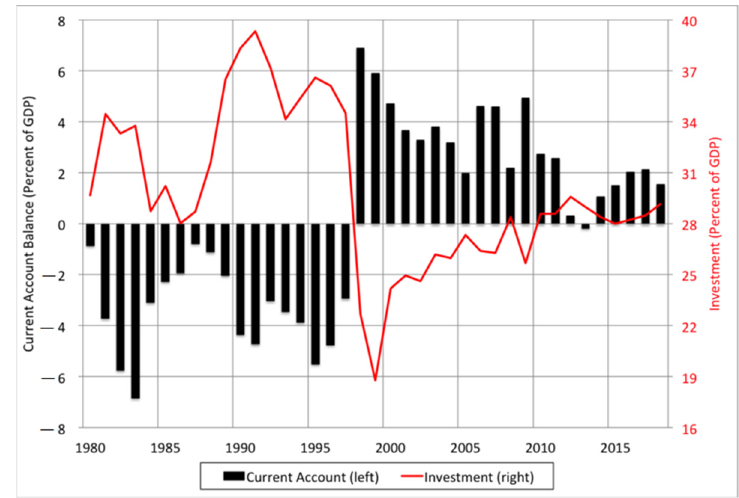
Figure 4. ASEAN-5 current account balance and investment, % of GDP (1980–2018). Source: IMF World Economic Outlook (WEO). ASEAN-5 includes Malaysia, Indonesia, Philippines, Singapore, and Thailand.